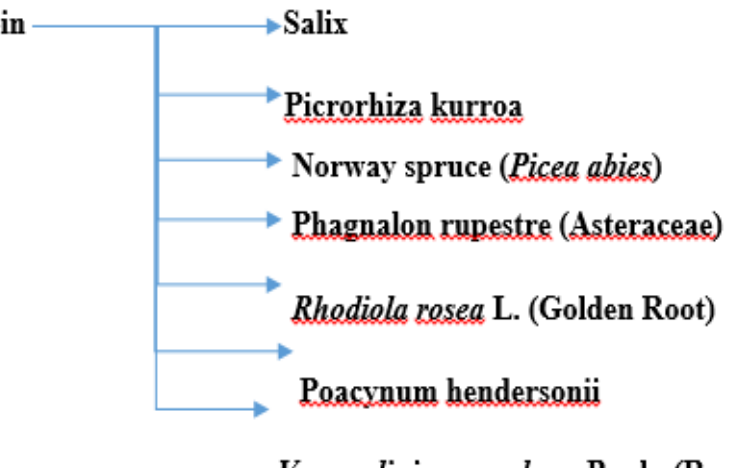
Figure 1. A summary of plants containing picein.